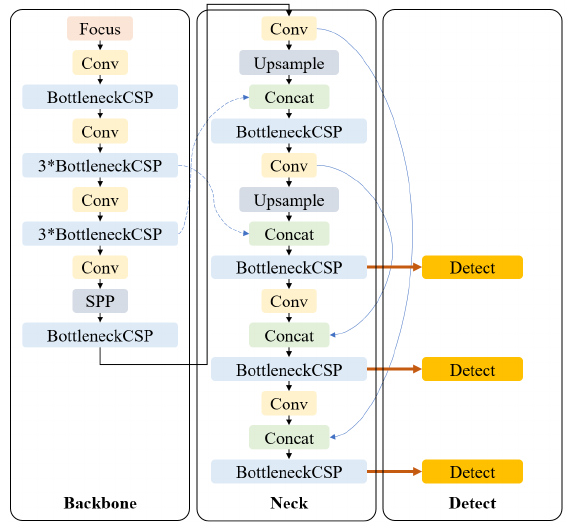
Figure 1 . Architecture of YOLOv5s (Yan et al.,